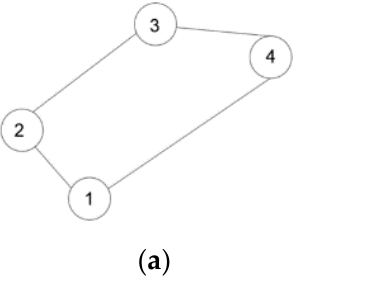
Figure 14. Case 2. ( a ) Undirected graph of four nodes; ( b ) merging graph of three sub-regions.